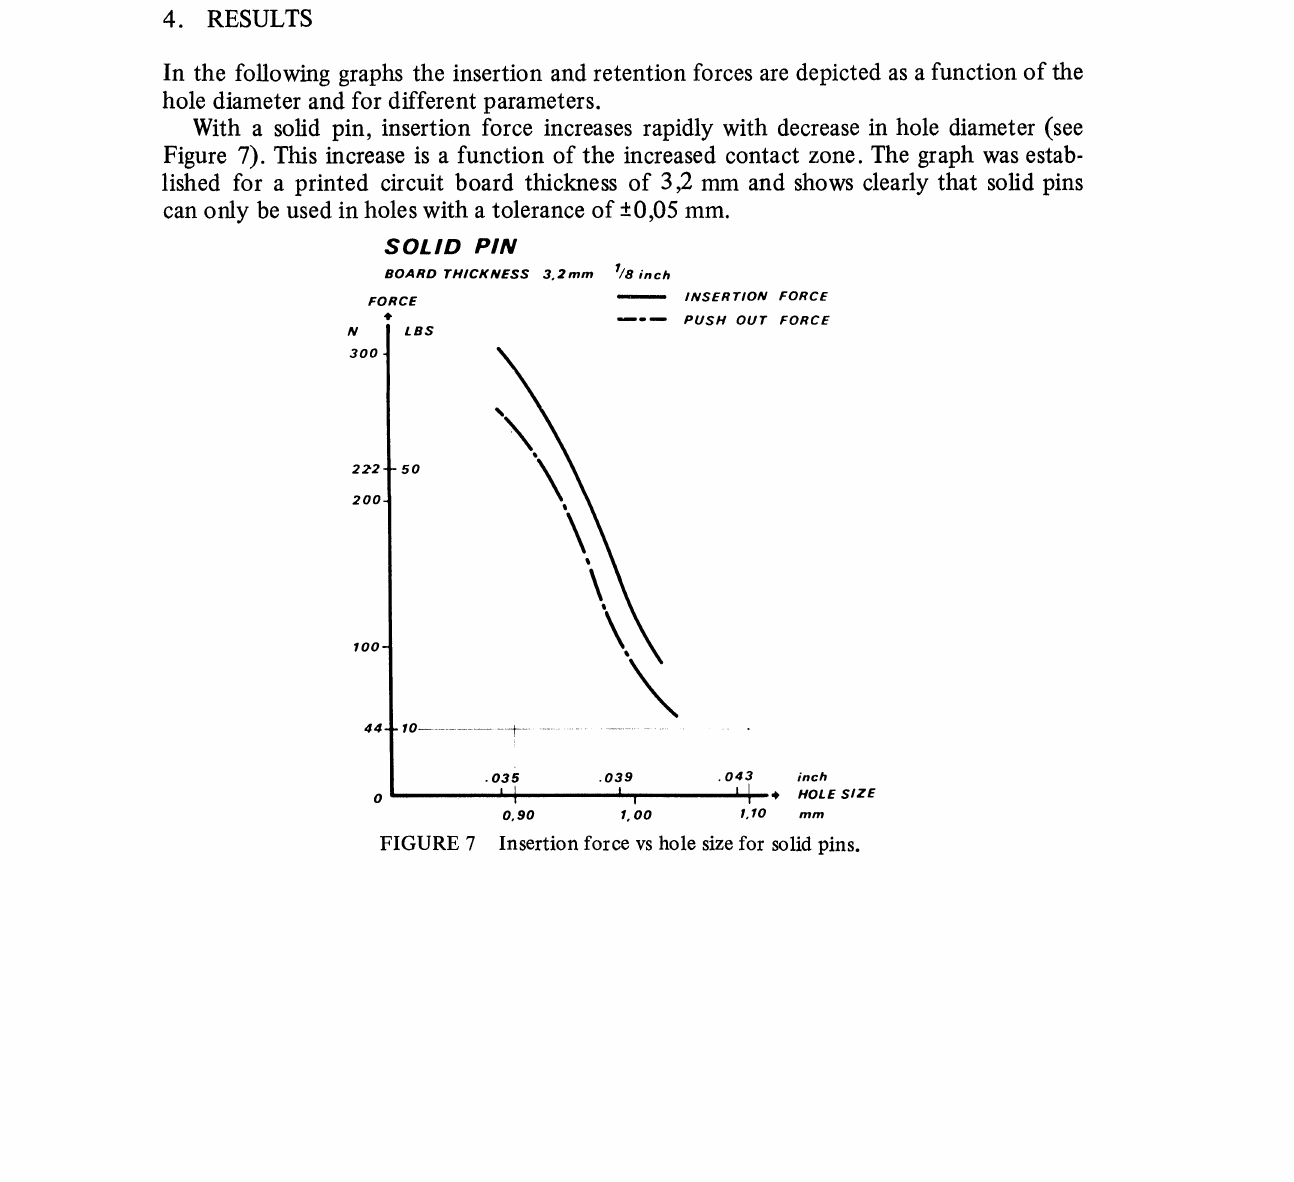
FIGURE 6 Effect of pressing pin into holes of different sizes.